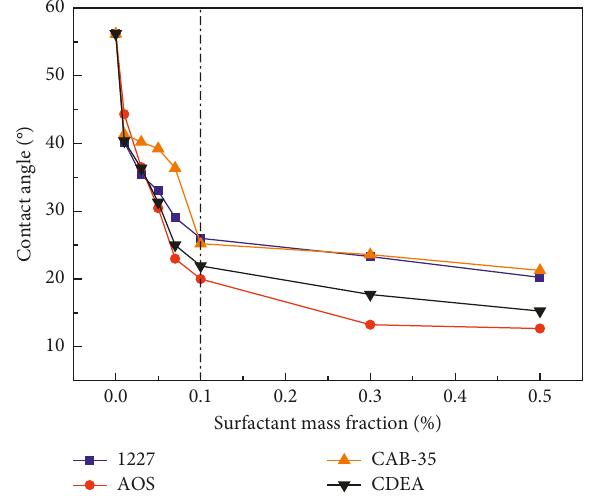
Figure 3: Contact angle of the surfactants at the different concentrations.